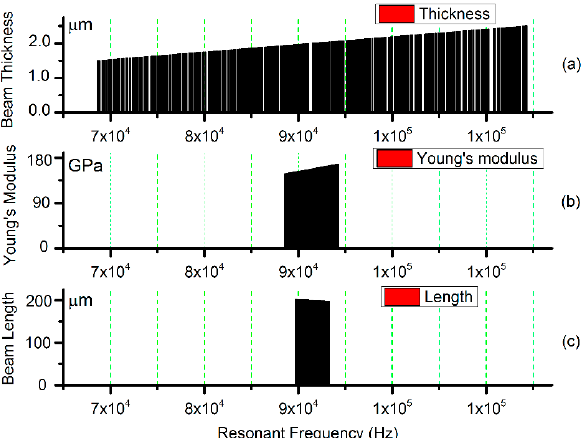
Figure 1. Sensitivity analysis of the resonant frequency for the doubly-clamped beam. ( a ) Beam thickness variable; ( b ) Young’s modulus variable; ( c ) Beam length variable.